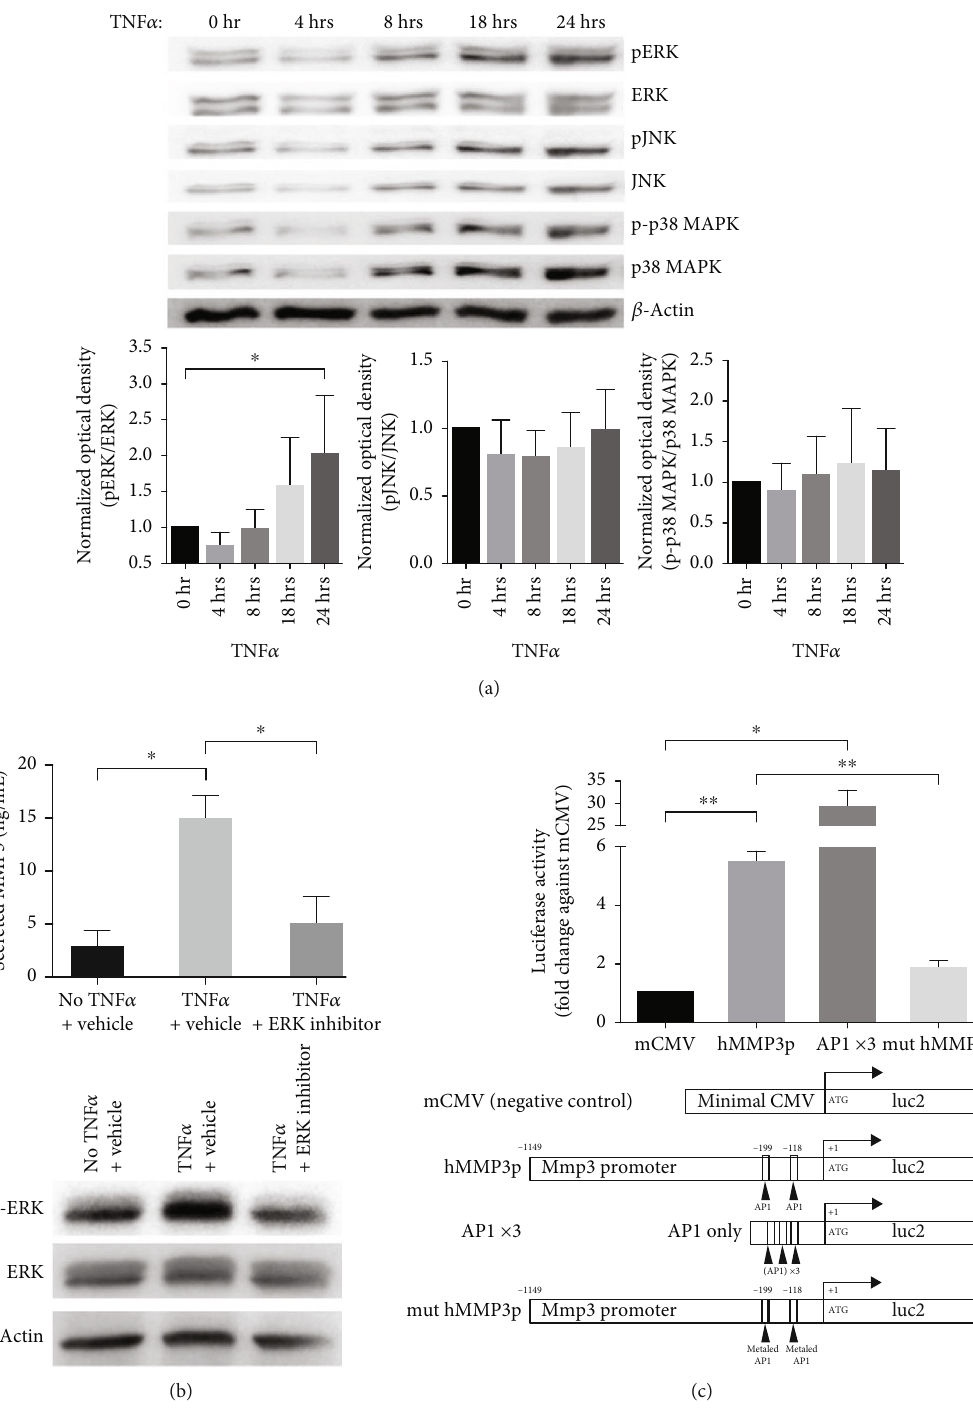
Figure 2: MMP3 expression induced by TNF α is mediated through ERK1/2 and AP1 activation in FDCLC. (a) TNF α induces ERK1/2 phosphorylation in FDCLCs. Time-course TNF α -treated FDCLCs were harvested and lysed, and ERK1/2 phosphorylation was then assessed by western blotting. The ImageJ densitometry plug-in was used for quantitative analysis. Among the MAPKs tested, only ERK1/2 phosphorylation was found to be signi fi cantly induced by TNF α . (b) TNF α -induced MMP3 expression is dependent on ERK1/2 activation. FDCLCs were pretreated with the ERK1/2 inhibitors U0126 and PD98059, and MMP3 secretion in the culture supernatant was analyzed. The inhibition of ERK1/2 phosphorylation was con fi rmed by western blotting, and MMP3 secretion was analyzed by ELISA. (c) Luciferase reporter assay for the AP1 binding site in the MMP3 promoter region. Diagrams indicate the vectors used. The MMP3p and AP1 luciferase activity was increased by TNF α , but not that of the AP1-mutated Mmp3p construct. Data shown are the mean values with standard deviation (SD) of three independent biological replicates; ∗ p < 0 : 05